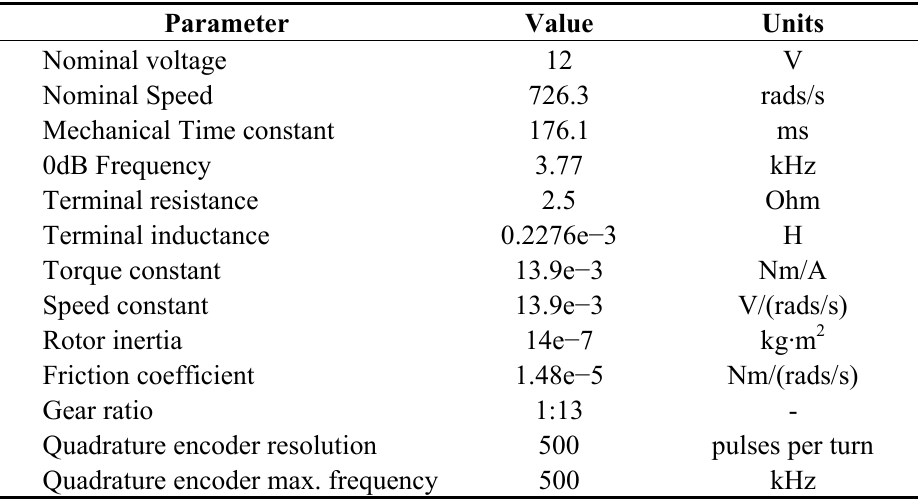
Table 1. Features of DC motor experiments.